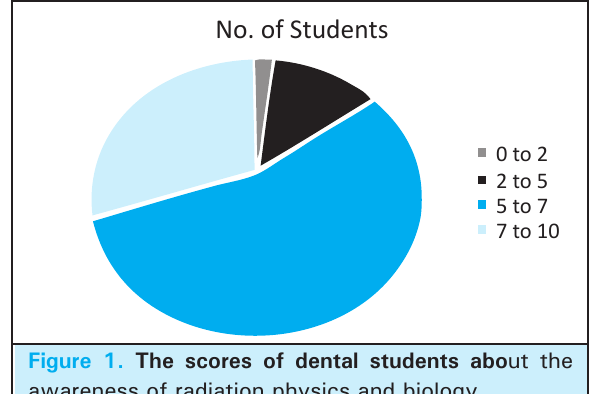
Figure 1. The scores of dental students abo ut the awareness of radiation physics and